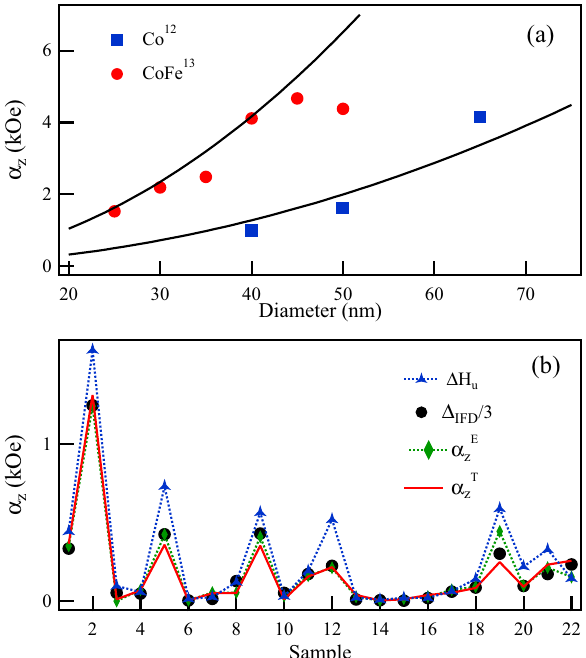
Figure 3. Interaction field coefficient, α z ( a ) calculated using Eq. (4) for Co and CoFe NWs (continuous lines) compared to the experimental values of (cid:31) H u reported in Refs. 12,13 , and ( b ) Comparison of the values of (cid:31) H u and � IFD / 3 measured from the FORC diagrams and the experimental ( α the axial component of the magnetization dependent interaction